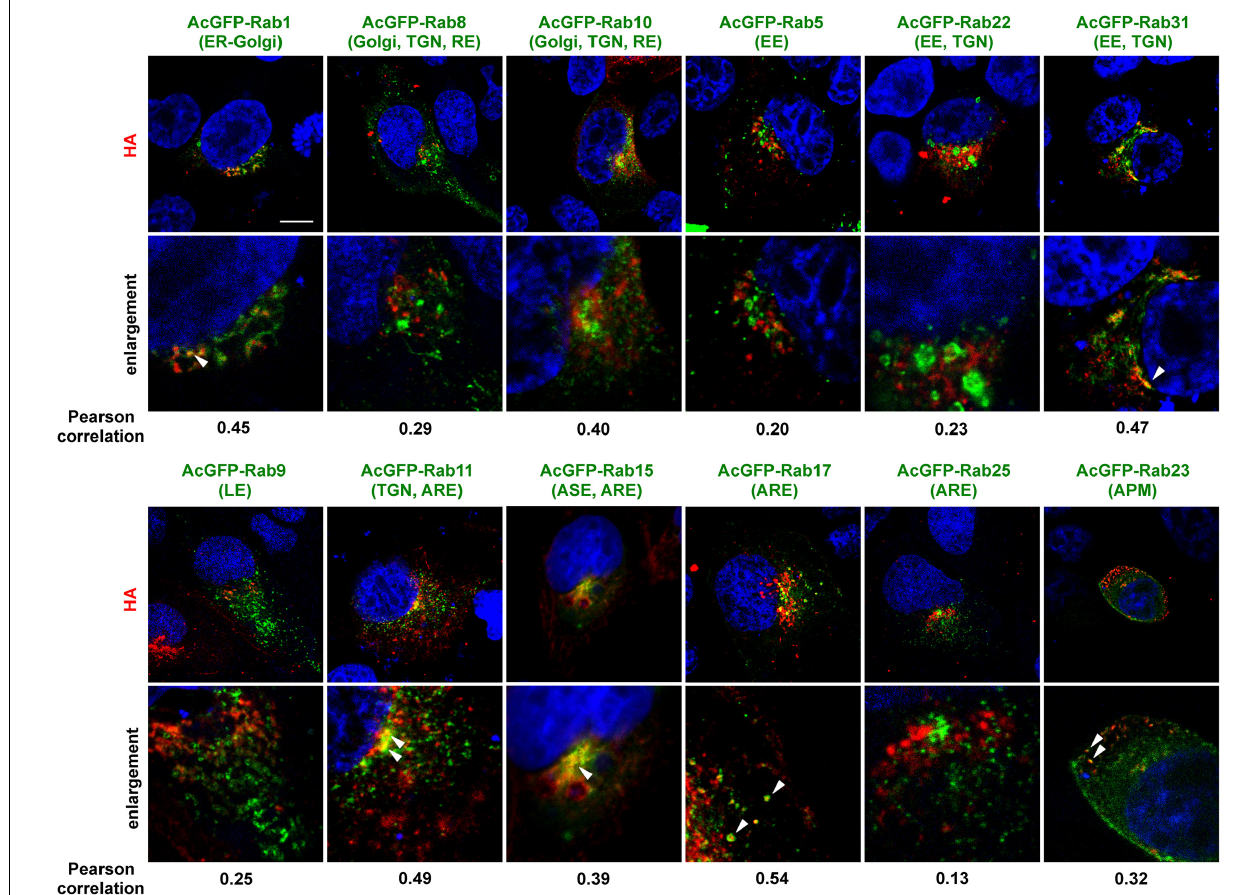
FIGURE 2 | Colocalization of AcGFP-Rab proteins with HA. Polarized MDCK cells were transiently transfected with AcGFP-Rab1, Rab5, Rab8, Rab9, Rab10, Rab11, Rab15, Rab17, Rab22, Rab23, Rab25, or Rab31 expression plasmids and then infected with influenza A virus. At 6 hpi, cells were stained with anti-HA mAb (red) and cell nuclei (blue) were stained with DAPI. Confocal images in the xy planes were shown. ER, endoplasmic reticulum; TGN, trans -Golgi network; EE, early endosome; LE, late, endosome; ARE, apical recycling endosome; ASE, apical sorting endosome; APM, apical plasma membrane. Arrowheads indicate colocalization of HA and AcGFP-Rab. All images were taken at the same magnification. Scale bar, 10 µ m. The Pearson correlation coefficient between HA and each Rab was also